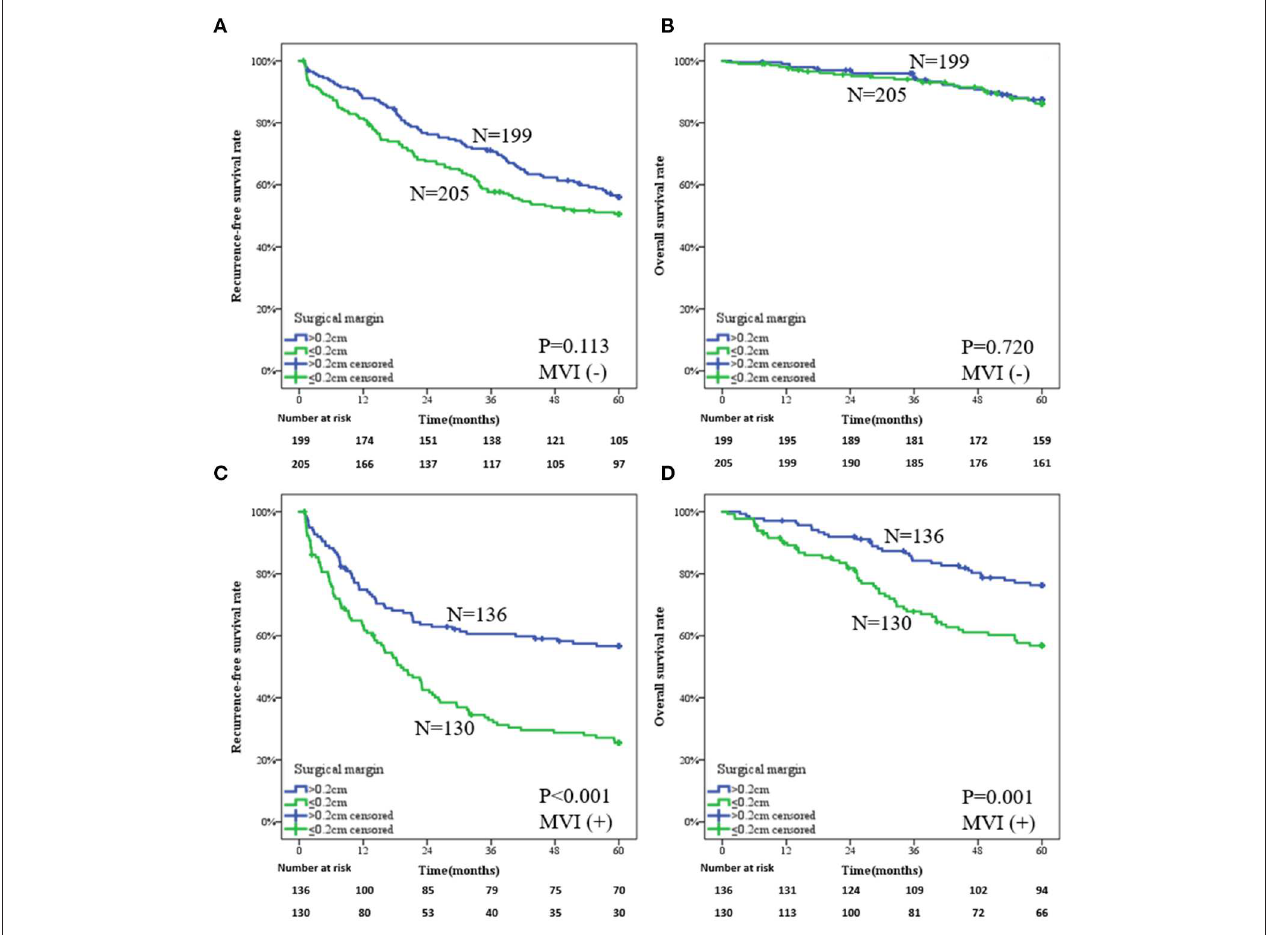
FIGURE 3 | Subgroup analysis of a wide-margin vs. a narrow-margin liver resection for the patients in the propensity score matching group. (A) Recurrence-free survival in the patients without microvascular invasion, (B) overall survival in the patients without microvascular invasion, (C) recurrence-free survival in the patients with microvascular invasion, (D) overall survival in the patients with microvascular